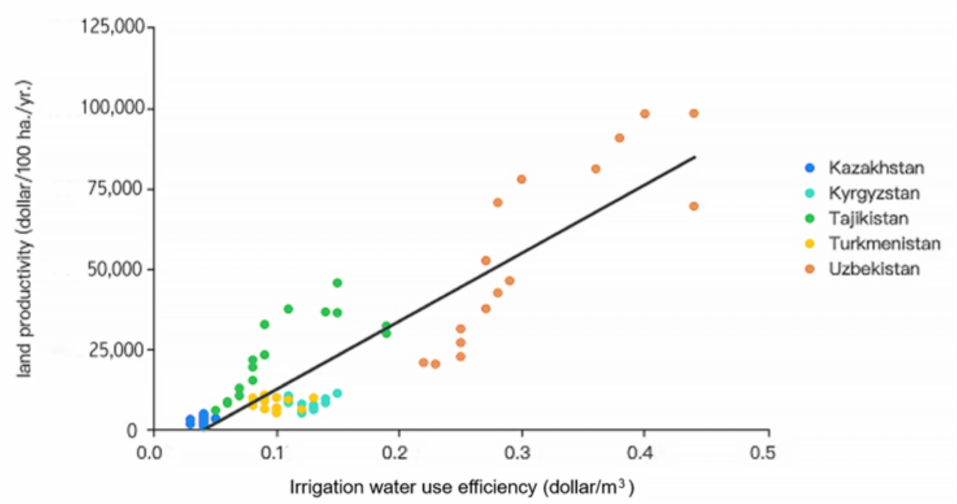
Figure 5. Relationship between irrigation water efficiency and land